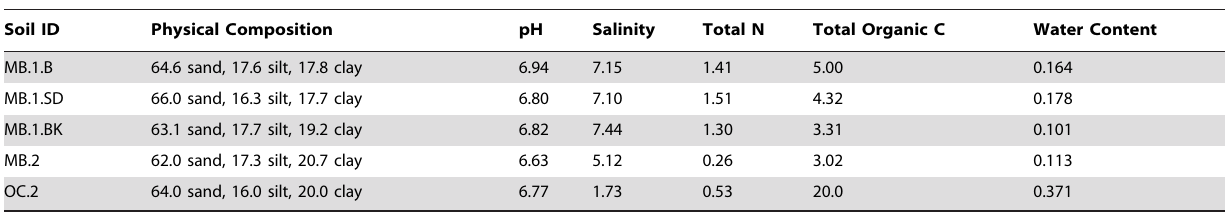
Table 1. Soil Physicochemical